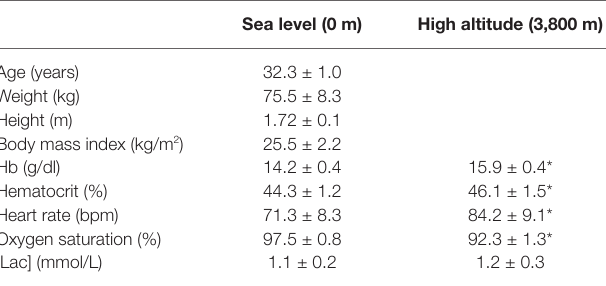
TABLE 1 | Characteristics of the study